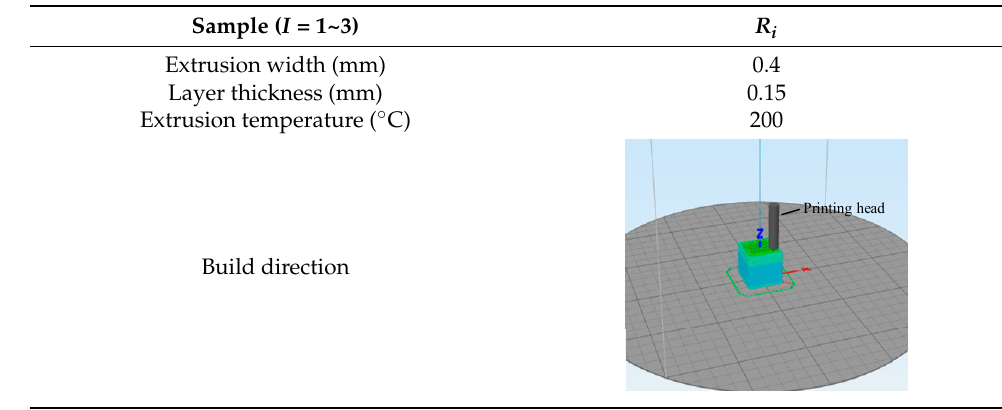
Figure 8. The ME equipment and testing samples: ( a ) ME device; ( b ) three-dimensional drawing of the samples. Table 2. Processing parameter settings.